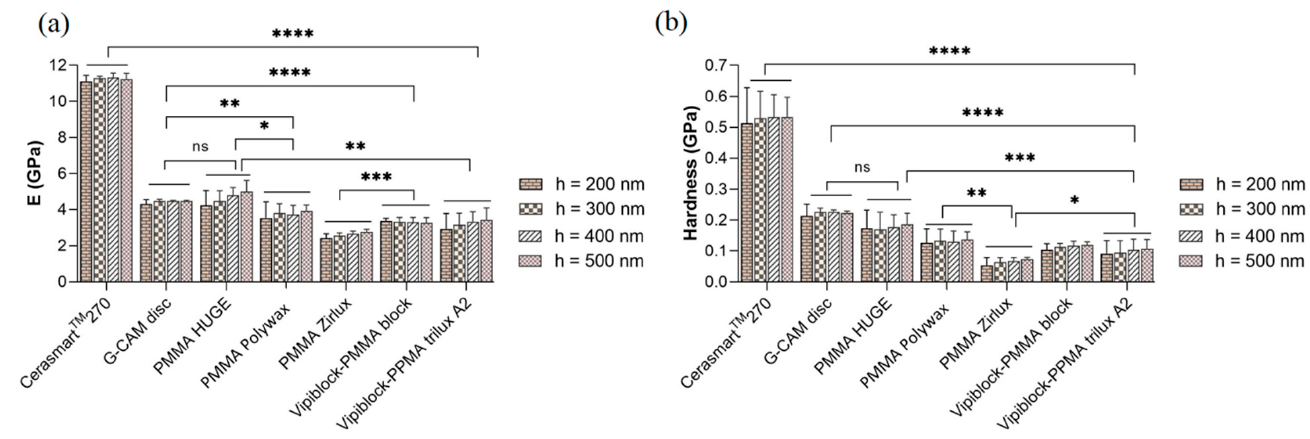
Figure 6. ( a ) Micro-elastic modulus (statistical significance: ns > 0.5; * p < 0.05; ** p < 0.005; *** p < 0.001; **** p < 0.0001) and ( b ) micro-scale hardness (statistical significance: ns > 0.5; * p < 0.05; ** p < 0.01; *** p < 0.0005; **** p < 0.0001) of all investigated CAD/CAM restorative specimens at different values of indentation depth.